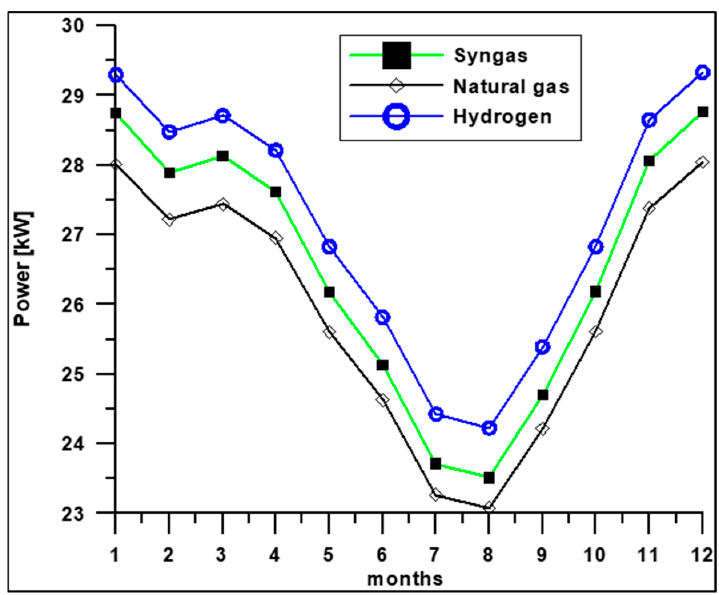
Figure 12. Net Power in a year in diurnal hours.